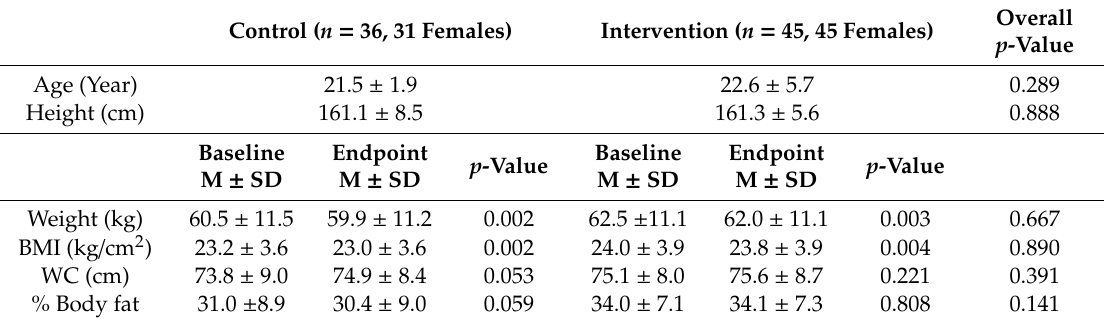
Table 1. Physical characteristics of the study population ( n =